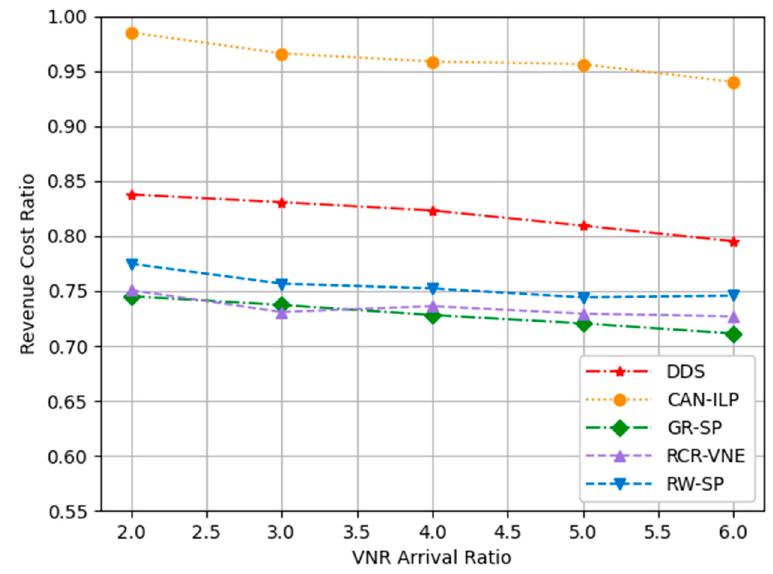
Figure 6. Revenue–cost ratio under various VNR arrival ratios.